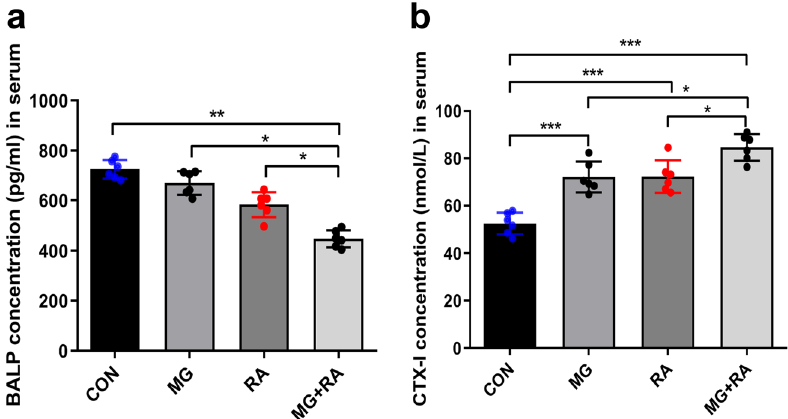
Fig. 6 Hindlimb unloading and X-ray radiation inhibited osteogenesis and increased bone absorption in rats as evidenced by serum analysis. a , b Serum analysis of BALP and CTX-1 in the four groups of rats ( n = 6). The data are expressed as the mean ± SD. * P < 0.05, ** P < 0.01, *** P < 0.001, ns not signi fi cant.